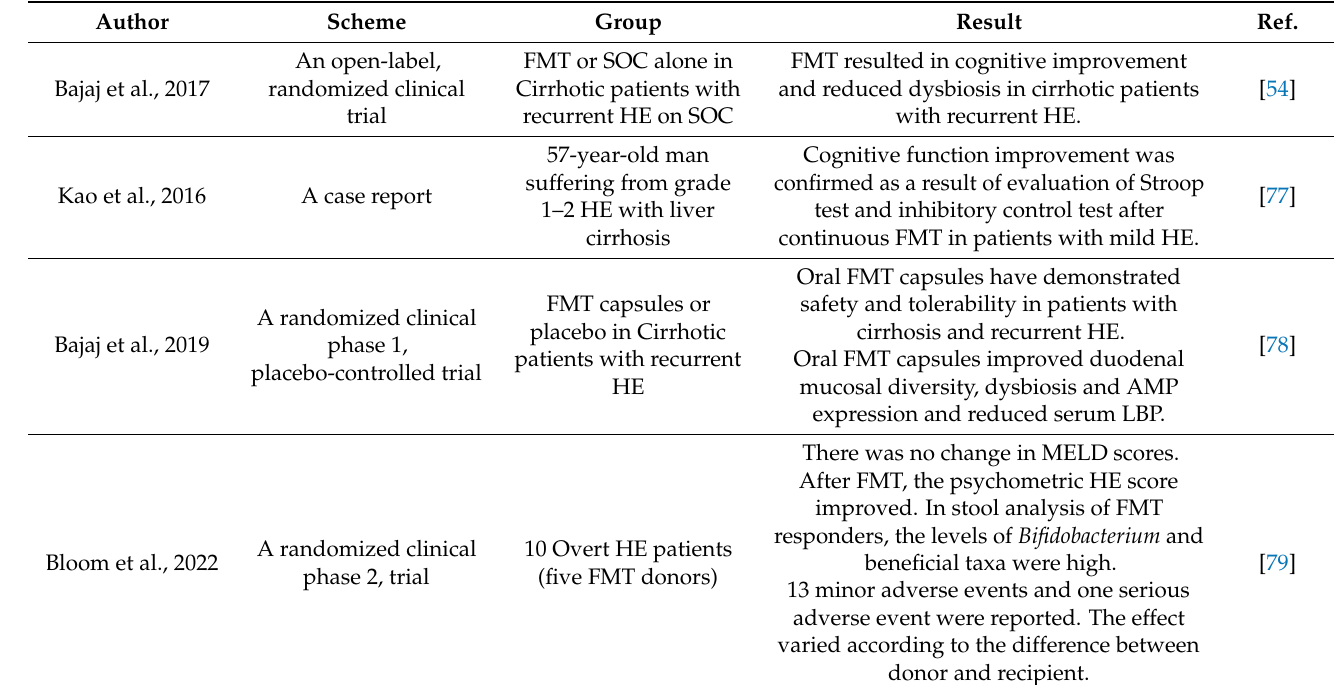
Table 3. Fecal microbiota transplantation therapies for hepatic